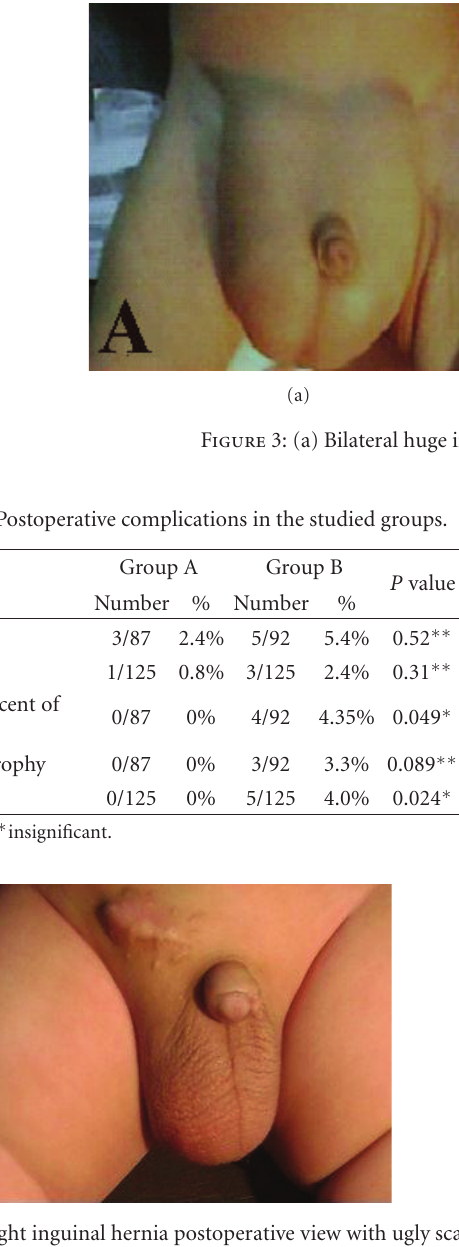
Figure 4: Right inguinal hernia postoperative view with ugly scar. reported by parents (Figure 4). The umbilical scars were not visible in all of the patients of group A.